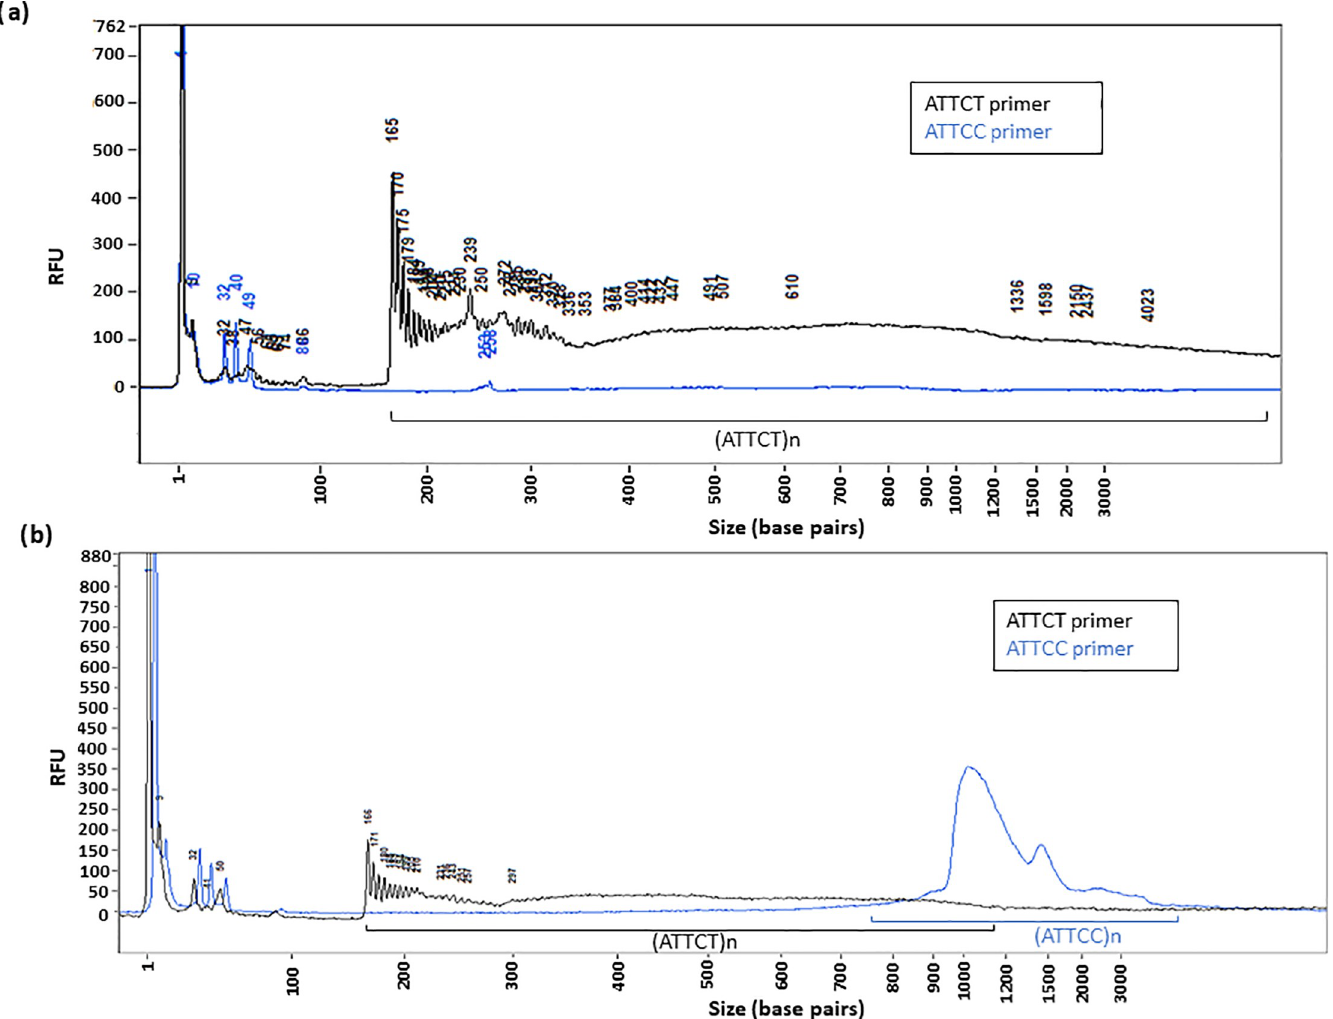
Fig 5. RP-FEMTO results of repeat maintenance upon transformation into a YAC in Saccharomyces cerevisiae . (a) RP-FEMTO results of genomic DNA using ATTCT (black line), ATTCC (blue line) internal primers of a pure ATTCT SCA10 pentanucleotide repeat transformed into a YAC and run on the RP-FEMTO using the small separation gel. As expected, no peak is present using the ATTCC primer since no ATTCC sequence should be present in this sample. (b) RP-FEMTO results of yeast genomic DNA using ATTCT (black line) or ATTCC (blue line) internal primers of an SCA10 pentanucleotide repeat containing an (ATTCC) n interruption transformed into a YAC and run on the FEMTO Pulse system using the small separation gel. Using the RP-FEMTO methodology, we were able to determine a (ATTCT) 188 and (ATTCC) 650 . There may exist some heterogeneity in the yeast population since there appears to be some overlap between the ATTCT repeat and ATTCC